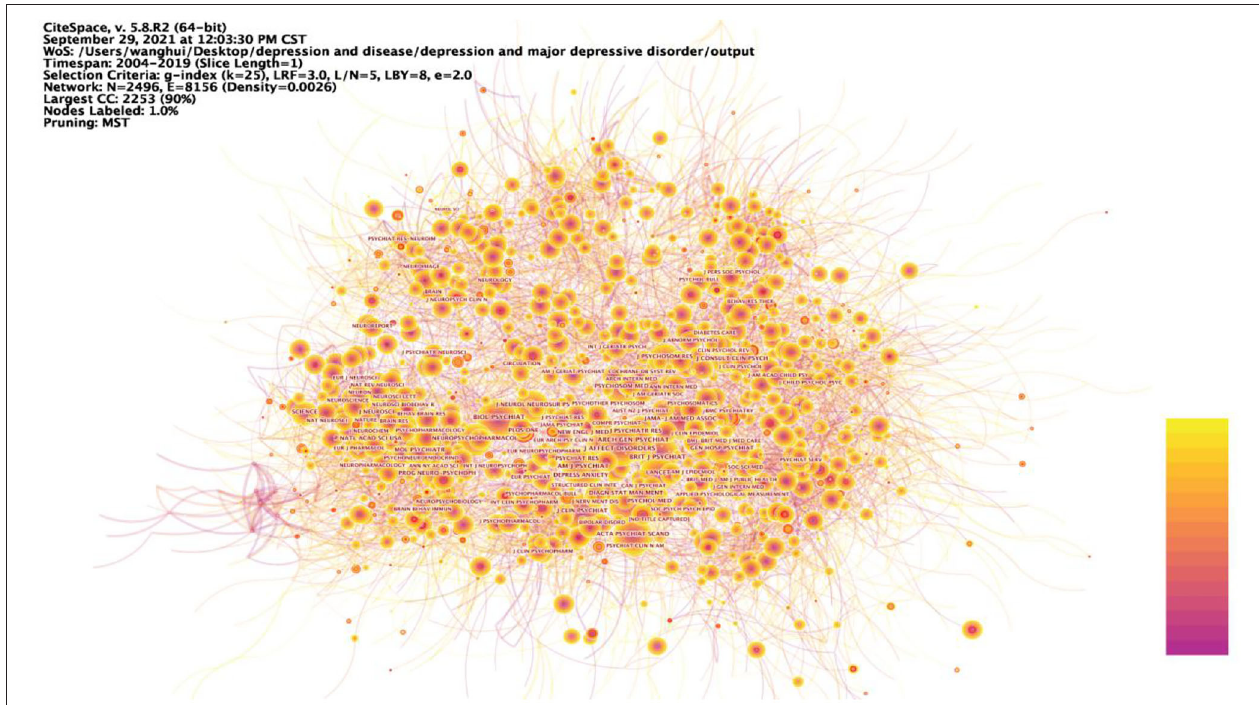
FIGURE 3 | Prominent journals involved in depression. The betweenness centrality of a node in the network measures the importance of the position of the node in the network. Two types of nodes may have high betweenness centrality scores: (1) Nodes that are highly connected to other nodes, (2) Nodes are positioned between different groups of nodes. The lines represent the link between two different nodes.